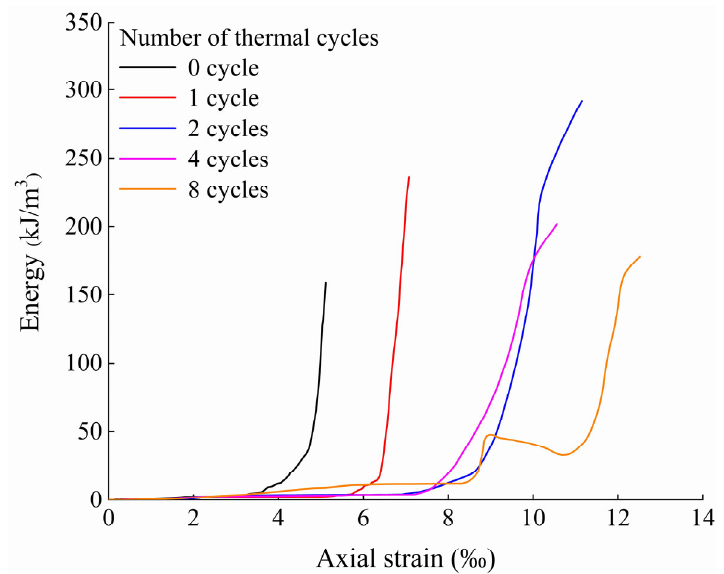
Figure 14. Variation in the dissipated energy of marble with axial strain during different numbers of thermal cycles under 0 confining pressure.